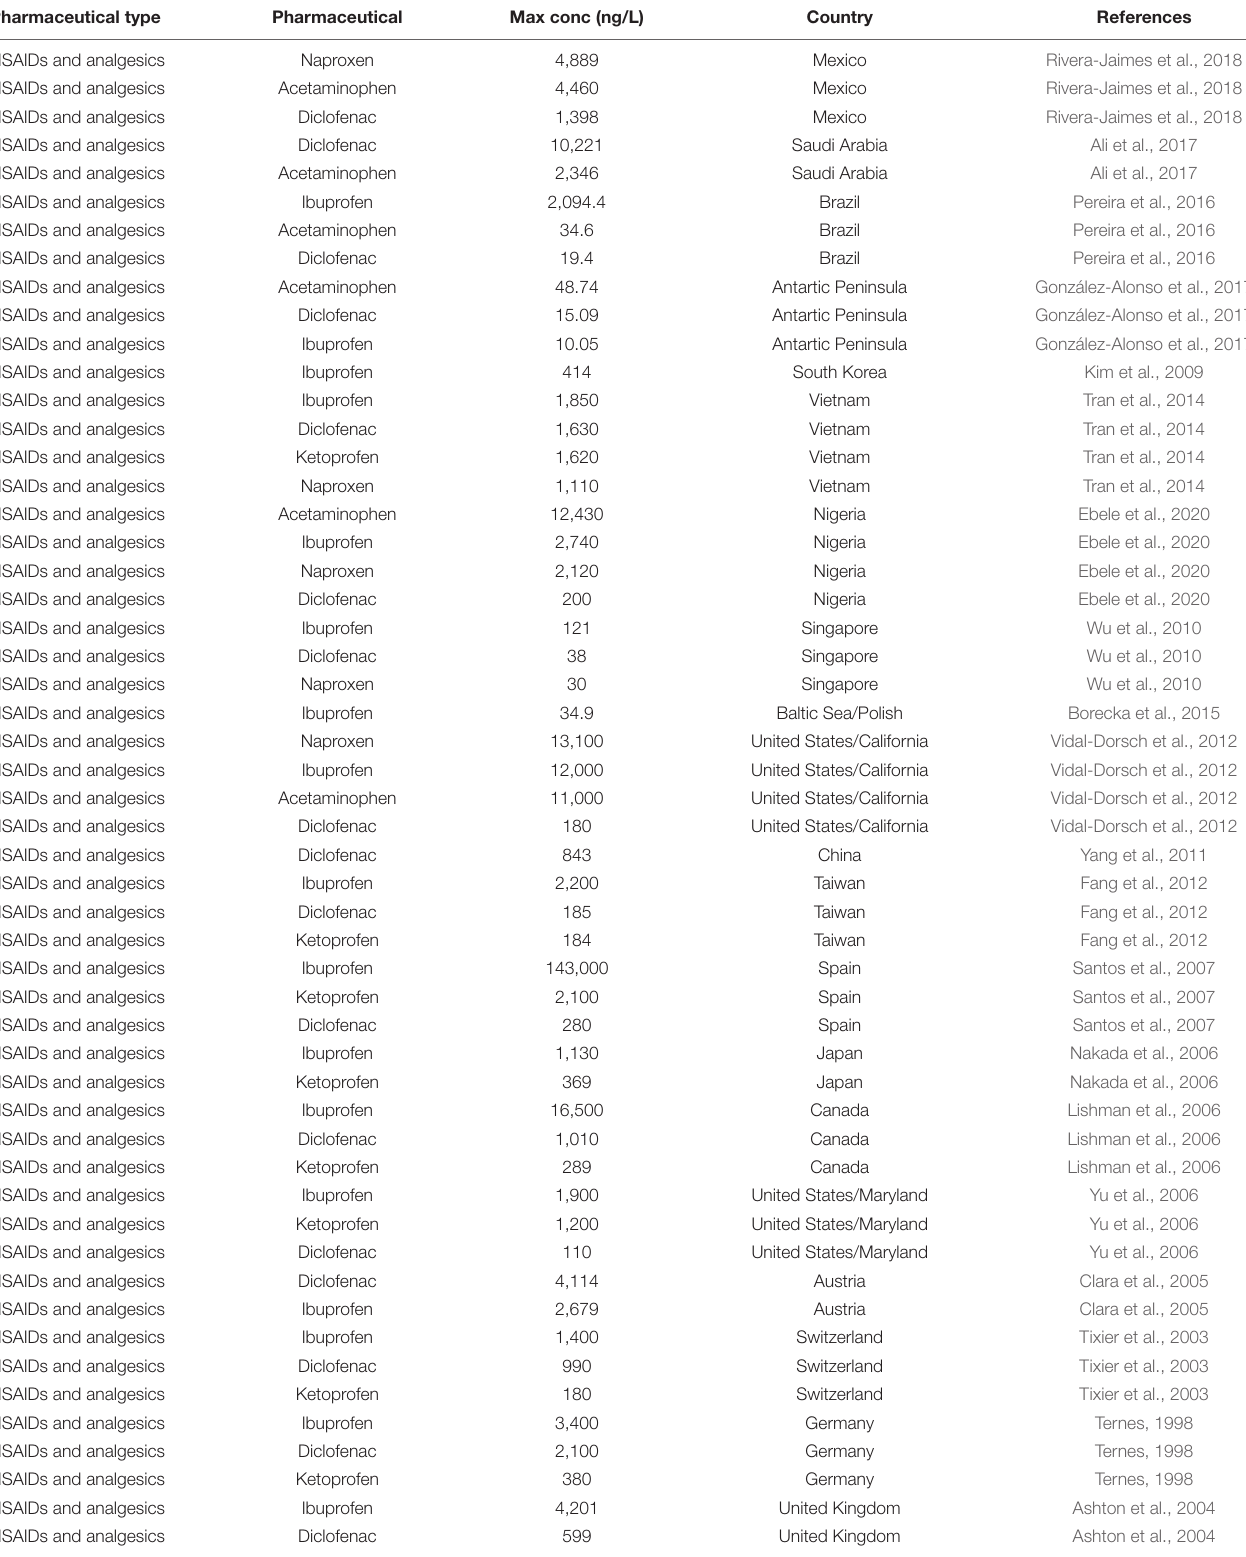
TABLE 1 | Types of pharmaceuticals and concentrations reported in countries